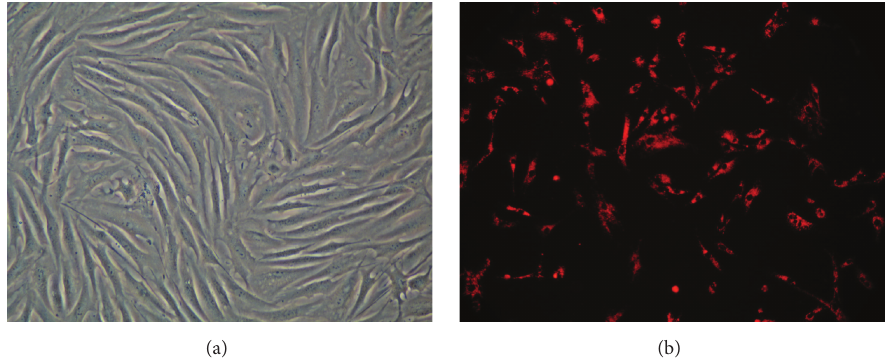
Figure 1: (a) Morphology of ASCs (P2) under an inverted phase contrast microscope; (b) CM-Dil labeled ASCs (P2) under a fluorescence microscope. The images were observed under a magnification of